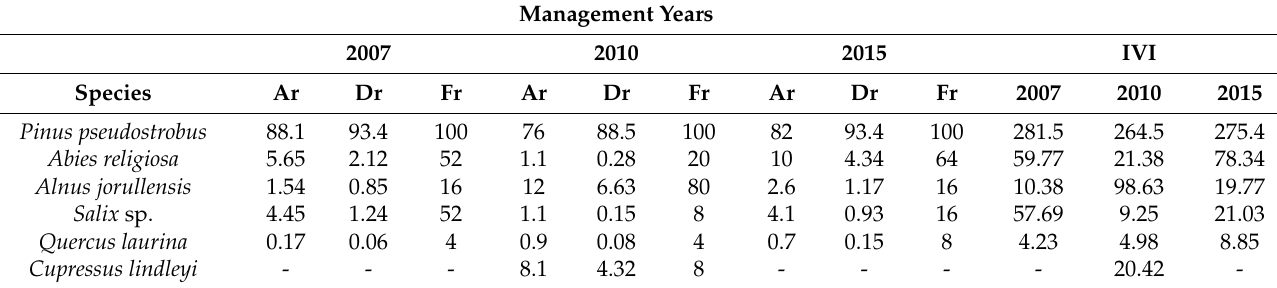
Table 1. Importance value index calculations for commercial tree species Palo Seco, Coatepec Harinas, Estado de M é xico for three harvesting periods. Relative abundance (Ar), relative dominance (Dr), relative frequency (Fr), importance value index (IVI).